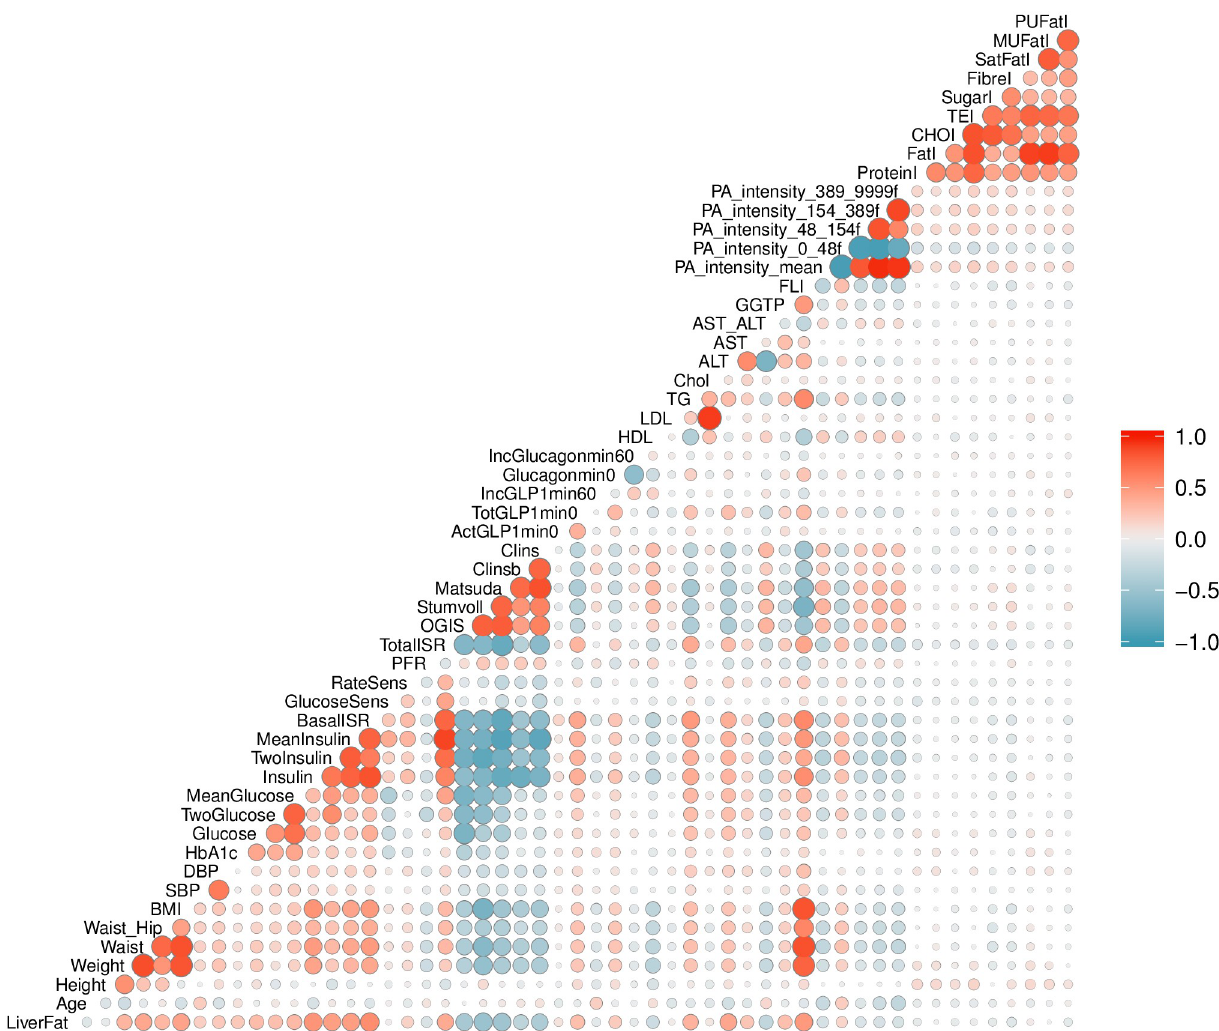
Fig 1. Pearson pairwise correlation matrix of clinical variables (data are inverse normal transformed) in the cohort combining participants with and without diabetes in IMI DIRECT ( n = 1,049). The magnitude and direction of the correlation are reflected by the size (larger is stronger) and color (red is positive and blue is negative) of the circles, respectively. ActGLP1min0, concentration of fasting active GLP-1 in plasma; ALT, alanine transaminase; AST, aspartate transaminase; AST_ALT, AST to ALT ratio; BasalISR, insulin secretion at the beginning of the oral glucose tolerance test/ mixed-meal tolerance test; BMI, body mass index; CHOI, total daily intake of dietary carbohydrates; Chol, total cholesterol; Clins, mean insulin clearance during the oral glucose tolerance test/mixed-meal tolerance test, calculated as (mean insulin secretion)/(mean insulin concentration); Clinsb, insulin clearance calculated from basal values as (insulin secretion)/(insulin concentration); DBP, mean diastolic blood pressure; FatI, total daily intake of dietary fats; FLI, fatty liver index; FibreI, total daily intake of dietary Association of Official Analytical Chemists (AOAC) fiber; GGTP, gamma-glutamyl transpeptidase; Glucagonmin0, fasting glucagon concentration; Glucose, fasting glucose from venous plasma samples; GlucoseSens, glucose sensitivity, slope of the dose–response relating insulin secretion to glucose concentration; HbA1c, hemoglobin A1C; HDL, fasting high-density lipoprotein cholesterol; IncGLP1min60, 1-hour GLP-1 increment; IncGlucagonmin60, 1-hour glucagon increment; Insulin, fasting insulin from venous plasma samples; LDL, fasting low-density lipoprotein cholesterol; Matsuda, insulin sensitivity index according to the method of Matsuda et al. [23]; MeanGlucose, mean glucose during the oral glucose tolerance test/mixed-meal tolerance test; MeanInsulin, mean insulin during the oral glucose tolerance test/mixed-meal tolerance test; MUFatI, daily intake of dietary monounsaturated fats; OGIS, oral glucose insulin sensitivity index according to the method of Mari et al. [24]; PA_intensity_0_48f, number of values in high-pass-filtered vector magnitude physical activity at � 0 and � 48; PA_intensity_154_389f, number of values in high-pass-filtered vector magnitude physical activity at � 154 and � 389; PA_intensity_389_9999f, number of values in high-pass-filtered vector magnitude physical activity at � 389 and � 9,999; PA_intensity_48_154f, number of values in high-pass-filtered vector magnitude physical activity at � 48 and � 154; PA_intensity_mean, mean high-pass-filtered vector magnitude physical activity intensity; PFR, potentiation factor ratio; ProteinI, total daily intake of dietary proteins; PUFatI, daily intake of dietary polyunsaturated fats; RateSens, rate sensitivity (parameter characterizing early insulin secretion); SatFatI, daily intake of dietary saturated fats; SBP, mean systolic blood pressure; Stumvoll, insulin sensitivity index according to the method of Stumvoll et al. [25]; SugarI, total daily intake of dietary; TEI, total daily energy intake based on validated multi-pass food habit questionnaire; TG, fasting triglycerides; TotalISR, integral of insulin secretion during the whole oral glucose tolerance test/mixed-meal tolerance test; TotGLP1min0, concentration of fasting total GLP-1 in plasma; TwoGlucose, 2-hour glucose after oral glucose tolerance test/mixed-meal tolerance test; TwoInsulin, 2-hour insulin; Waist_Hip, waist to hip ratio.